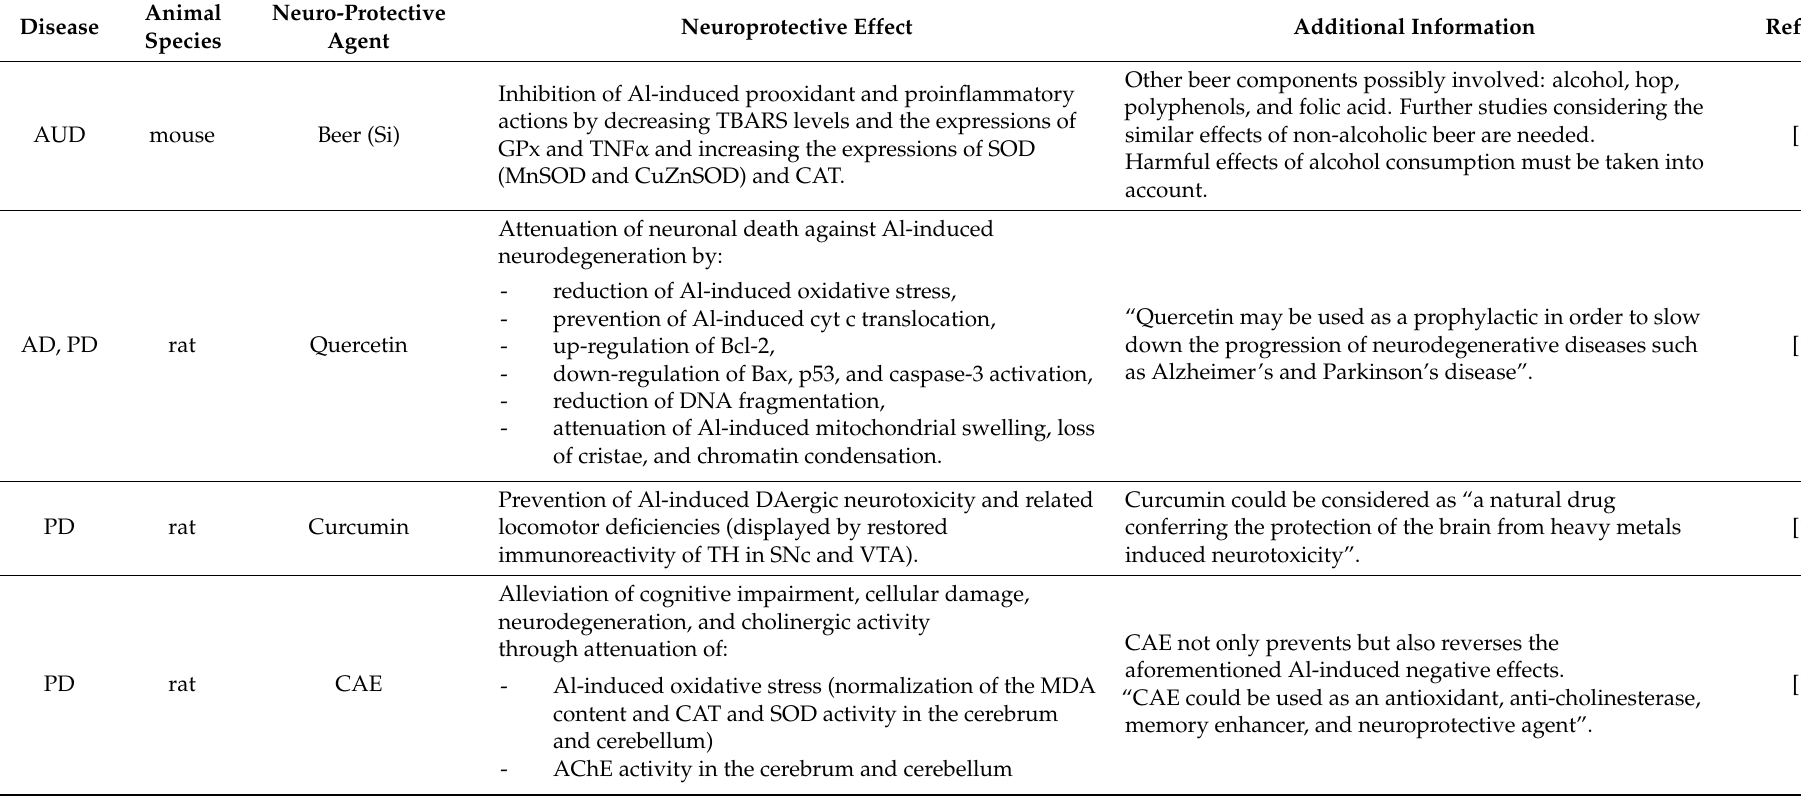
Table 5. Potentially neuroprotective agents for Al-induced diseases found in animal